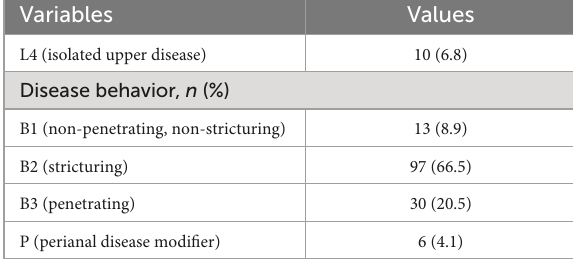
TABLE 1 Basic information, body composition analysis and subtypes of the Crohn’s disease patients ( n =